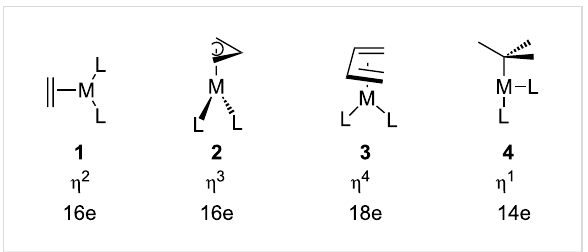
Figure 1: The four coordination geometries for d 10 polyene-ML 2 com- plexes along with their hapto numbers and electron count.